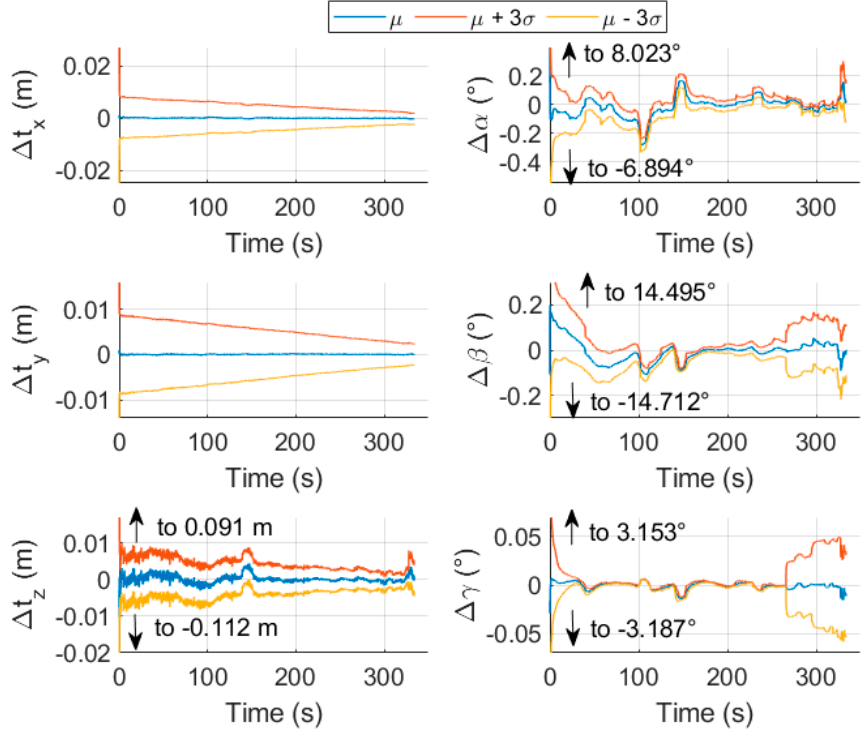
Figure 17. Temporal evolution of the mean of the errors on the pose parameters, with representation of the 3 σ intervals, for test case I. The plots are focused on intervals about the mean values: the arrows indicate the maximum values reached by the pose initial guess at scenario start. Table 14. Mean and standard deviation of the pose estimation errors for a higher uncertainty in the knowledge of the initial condition, for test case I.